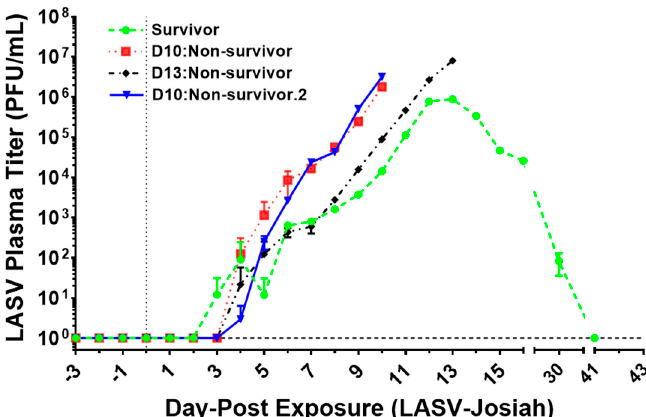
Figure 3. Time course of Lassa virus detection in plasma of challenged cynomolgus macaques. Detection was conducted using qRT-PCR to amplify RNA using specific primers for the S segment of the Lassa virus (LASV) glycoprotein gene. DPE 0 marked by vertical dot line and average by horizontal dash line. ( ● Survivor) ( ■ D10:Non-survivor) ( ♦ D13:Non-survivor) ( ▼ D10:Non-survivor).